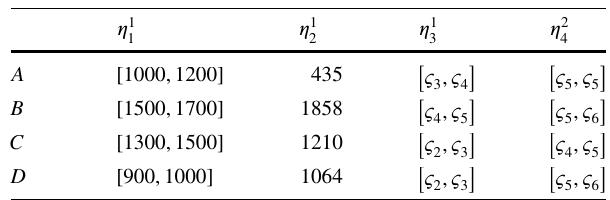
Table 3 Evaluation values of indicators 𝛿 1 = Table 4 Evaluation values of indicators 𝛿 2 =